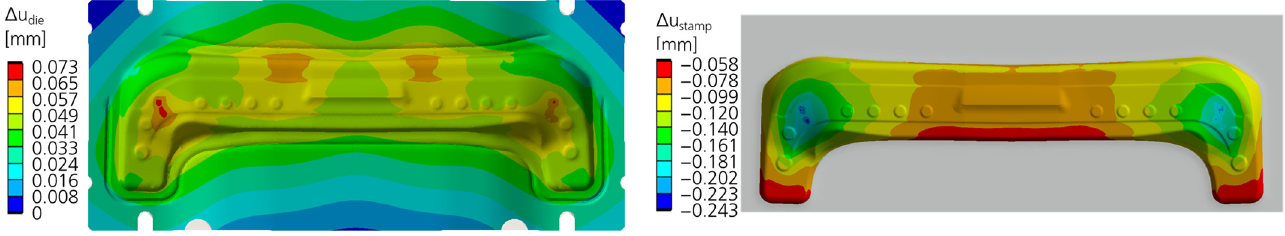
Figure 6. Displacement of active surface of die and stamp due to applied forming process pressure distribution on both sides of the active surfaces in contact with the metal sheet (calculated with ideal stiff press behavior).